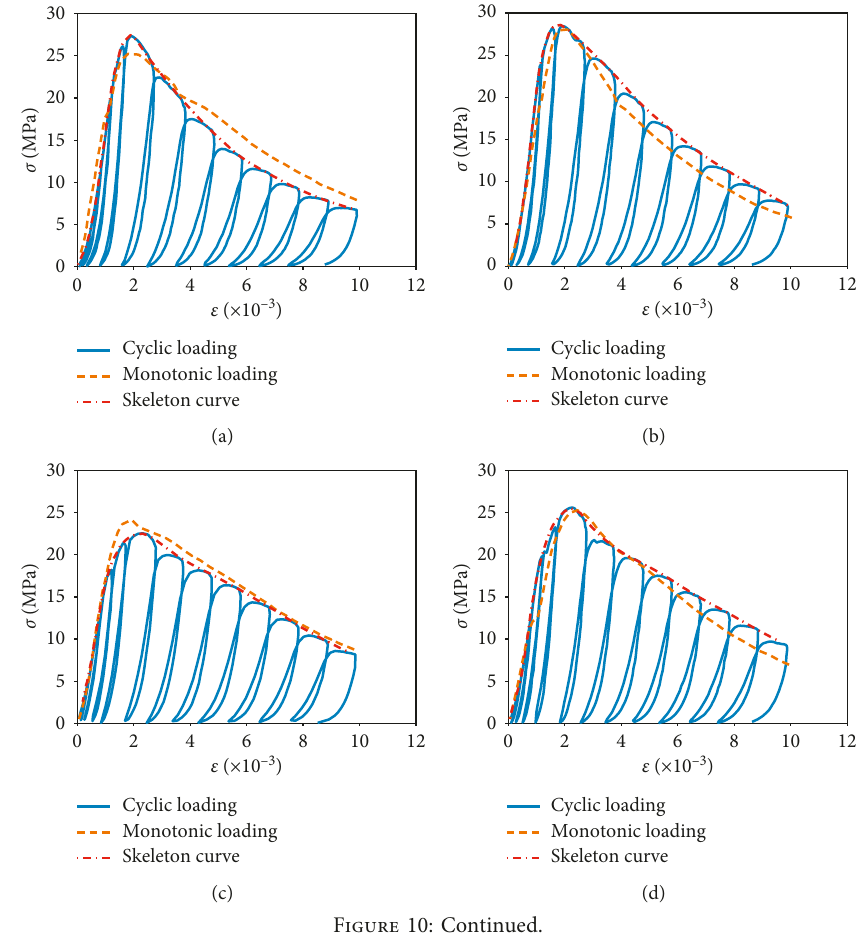
E corresponding to (a) equation (7) and (b) equation